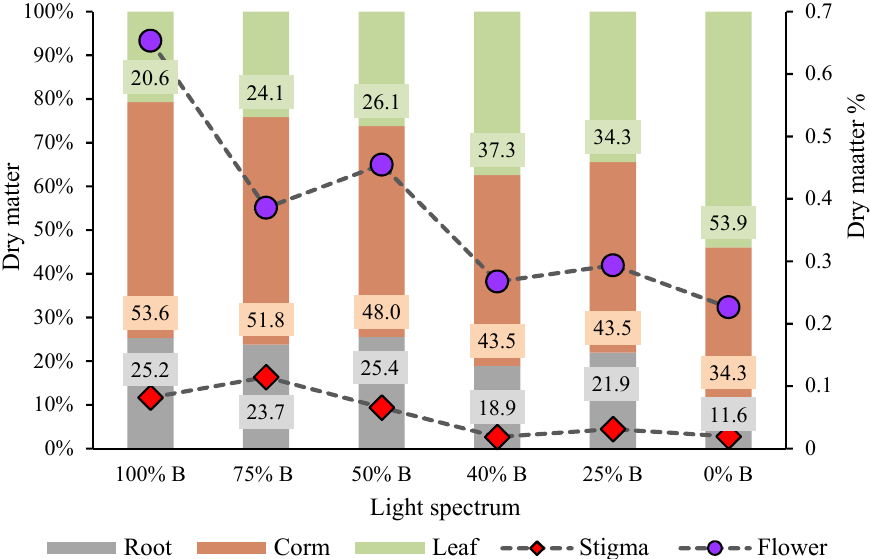
Figure 4. Biomass partitioning of saffron plants grown under different ratios of Blue (B) to Red (R) light in the overall spectral composition, including 100% B, 75% B, 50% B, 40% B, 25% B, 0% B (see the spectrum in Figure 1), with 150 ± 10 µ mol m − 2 s − 1 PPFD. Due to the allocation of less than 1% of total dry matter to the reproductive organs, flower and stigma dry matters are shown by purple circles and red rhombus, respectively, showing their values by the right Y